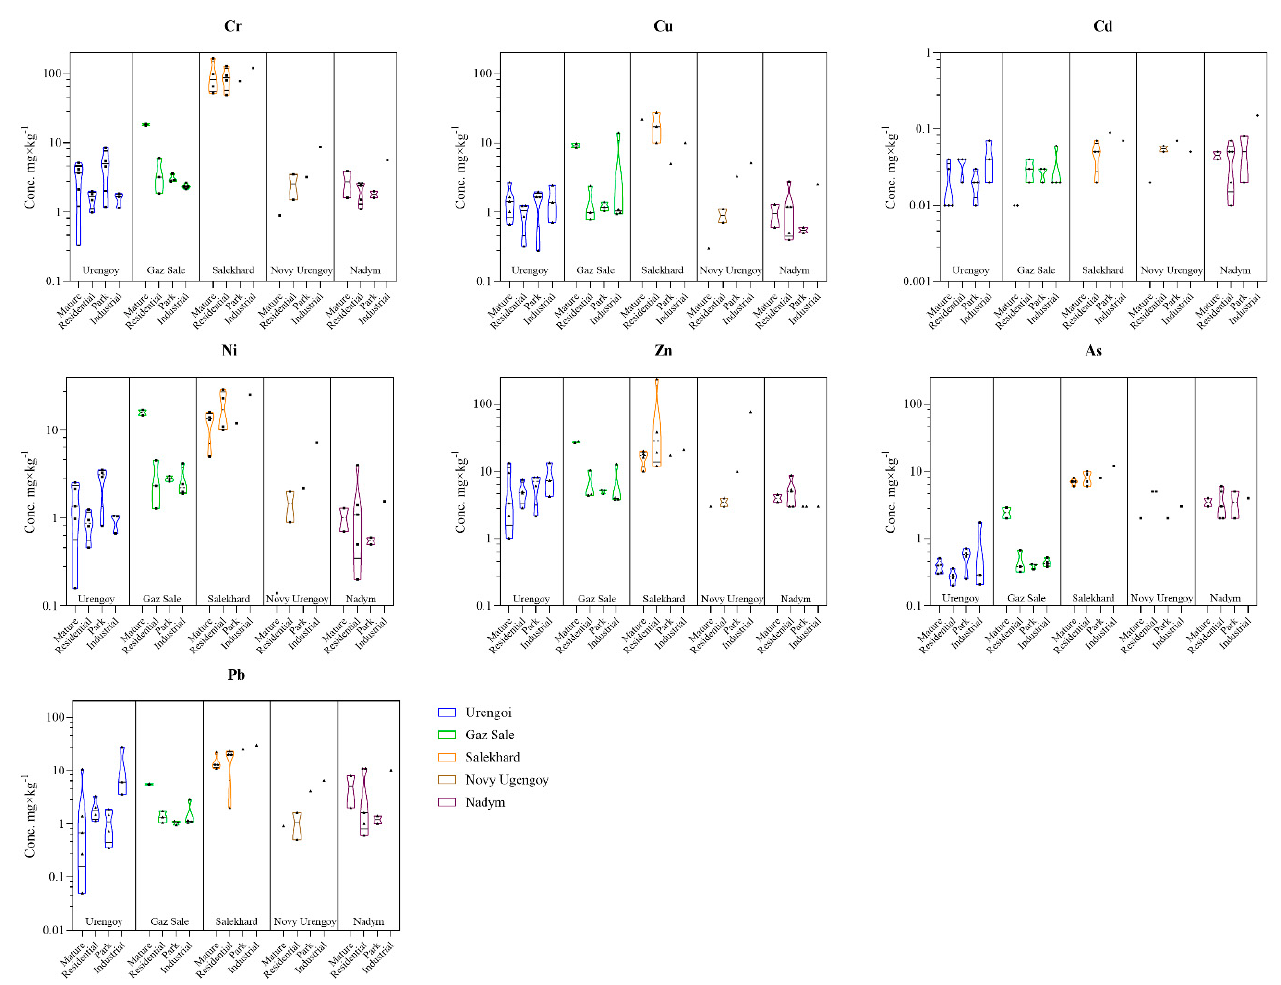
Figure 6. Content of trace metals in topsoil (0–20 cm) of Arctic cities and their functional zones.